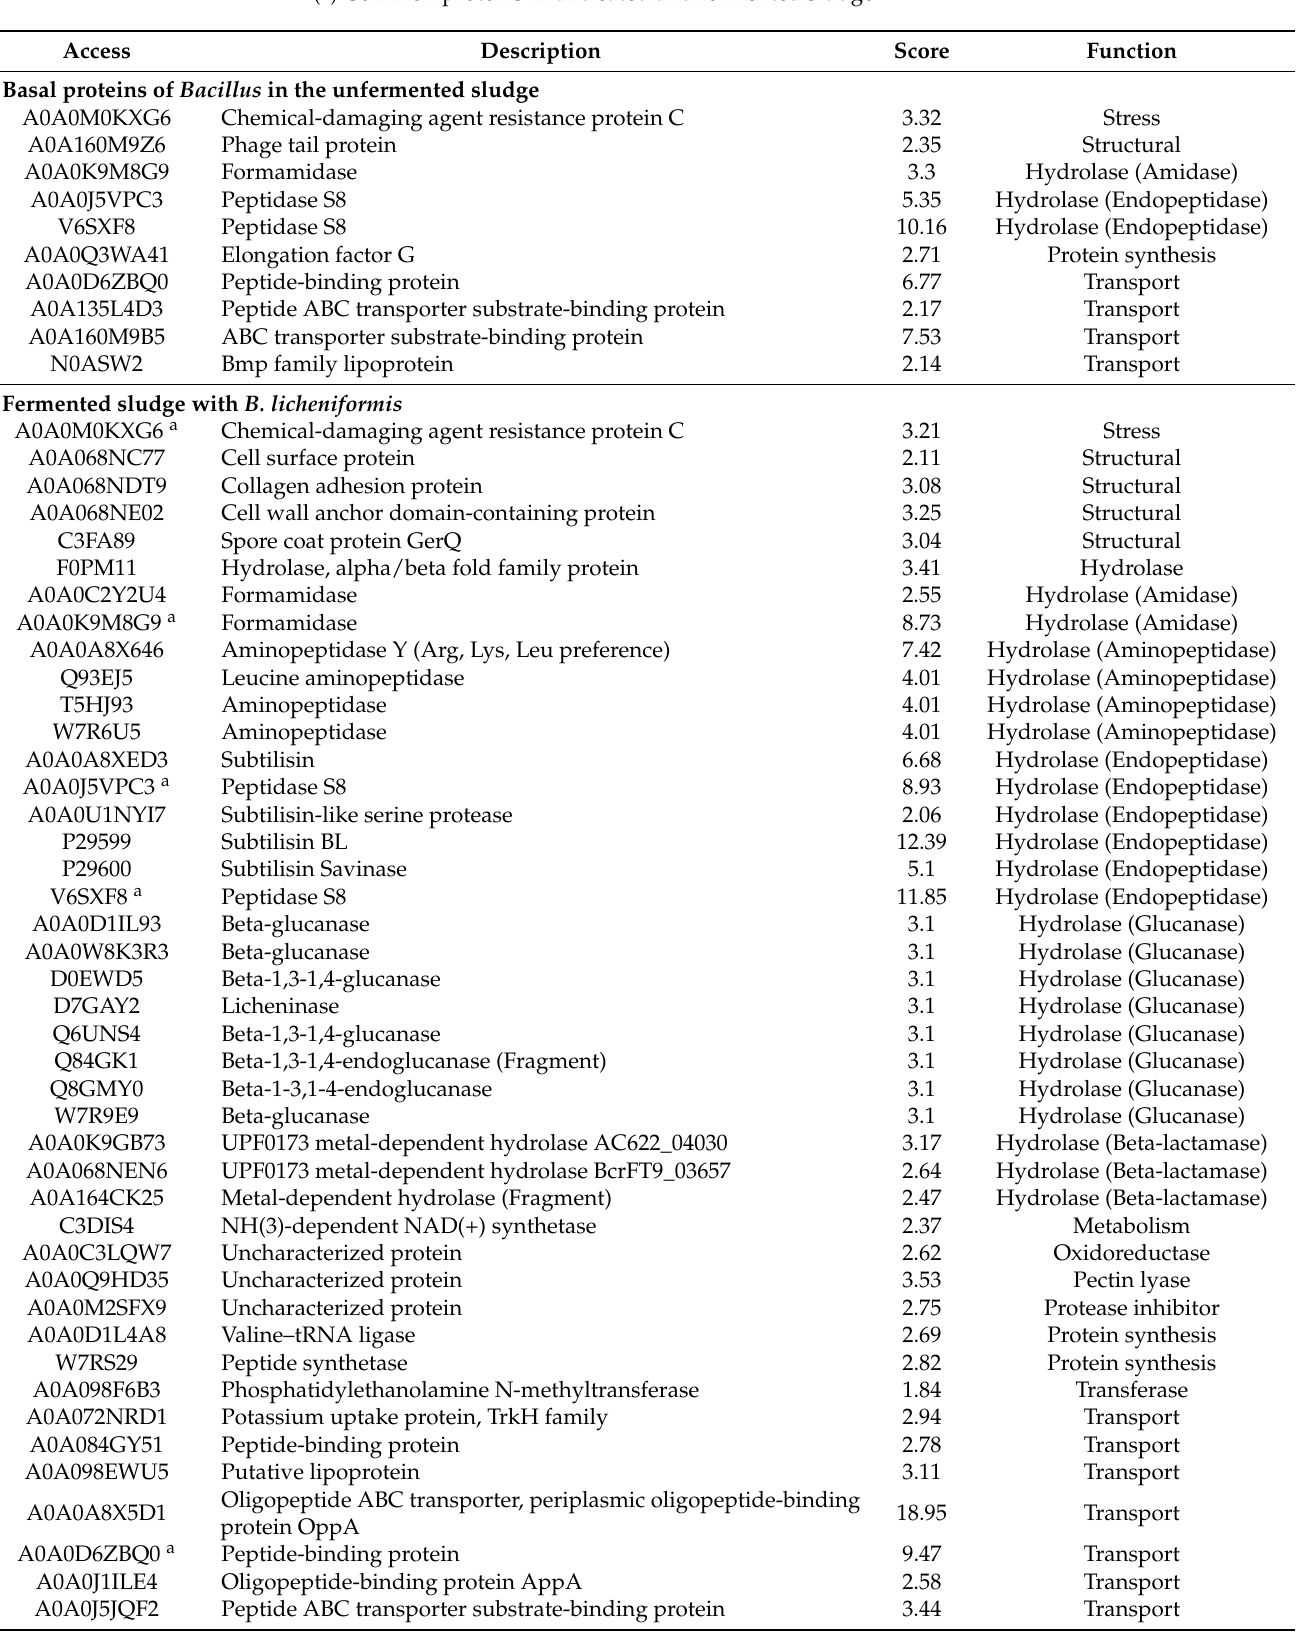
Table 2. The identification of Bacillus extracellular proteins in both the untreated and fermented sludge with B. licheniformis , using the Sequest search engine pitted against the UniProt database. ( a ) Common proteins in untreated and fermented